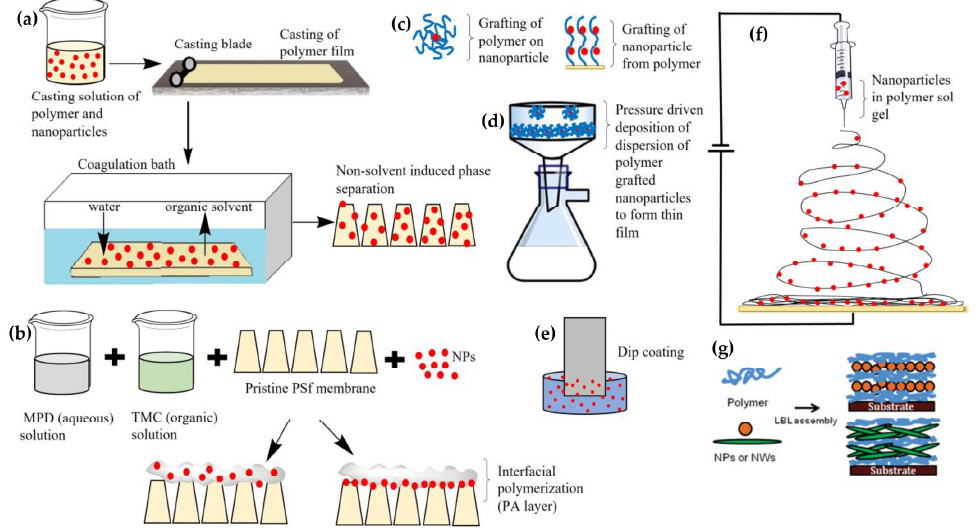
Figure 1. Various methods of integrating nanoparticles with polymer to form polymer nanocompo- site membranes: ( a ) Schematic representation of one of the phase inversion methods (non-solvent- induced phase separation) for fabrication of polysulfone (PSf) layer. ( b ) Integration of nanoparticles either in the polyamide (PA) layer or as a thin layer at the bottom of the PA layer on top of PSf layer in nanocomposite membrane using interfacial polymerization method (MPD—m-phenylenedia- mine, TMC—trimesoyl chloride). ( c ) Short polymer strands grafted on a nanoparticle surface or na- noparticles grafted from the polymer membrane. ( d ) Pressure driven filtration of dispersion/solu- tion of polymer and nanoparticles (polymer grafted nanoparticles example in this case). ( e ) Dip coating of polymeric membrane in a dispersion/solution containing nanoparticles. ( f ) Electrospin- ning of nanoparticles added in sol–gel ( g ). Layer-by-layer assembly of polymer and nanoparticles (NPs—nanoparticles, NWs—nanowires), [83] , © American Chemical Society, 2008. For easy inter- pretation, spherical shapes are used for nanoparticles in most of the figures. NPs differ from their larger bulk materials in that their size, shape, and dimension- ality affect their properties and performance as a material. Specifically, when their size is reduced, the particles have extremely high specific surface area and surface-area-to-vol- ume ratios. In a nanomaterial, at least one of the dimensions is in the nanoscale range of 1–100 nm. The nanomaterials are classified into zero-dimensional (0D), one-dimensional (1D), two-dimensional (2D), and three-dimensional (3D) nanomaterials. In 0D nano- materials, all three dimensions are at the nanoscale. Examples include quantum dots, core shell NPs, nanospheres, etc. In 1D nanomaterials, two dimensions are at the nanoscale, giving the structures a rod like shape. Examples include nanowires, nanofibers, and nano- tubes. In 2D nanomaterials, one dimension is at the nanoscale, giving the structures a sheet-like topology, e.g., graphene sheets. The 3D nanomaterials are not confined to the nanoscale in any dimension, which can include polycrystals, bundles of nanowires or nanotubes, and nanoporous solids. Examples include graphite, dendrimers, liposome, etc. [84]. For illustration, various dimensionalities of carbon allotropes are shown in Figure 2. The nanomaterial properties can be fine-tuned as desired by precisely controlling the size, shape, synthesis conditions, and necessary functionalization.